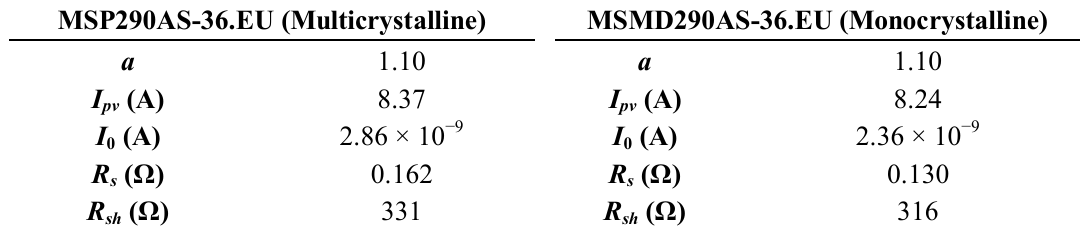
Table 4. Parameters of MSP290AS-36.EU and MSMD290AS-36.EU (München cell temperature, AM1.5g